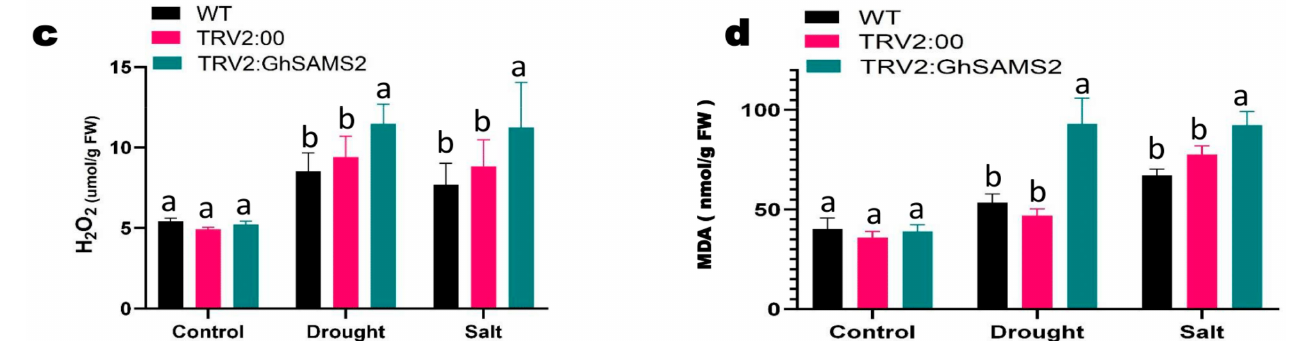
Figure 5. Oxidant and antioxidant enzyme biochemical assays in the leaves of WT and VIGs plants af- ter 24 h post-stress-exposure. ( a ) Determination of catalase quantity. ( b ) Determination of peroxidase quantity. ( c ) Determination of hydrogen peroxide quantity. ( d ) Determination of Malondialdehyde quantity. TRV2:00, Positive control; WT, Wild type; and TRV2: GhSAMS2 , VIGS plants. Different letters above the bars indicate statistically significant differences at p <